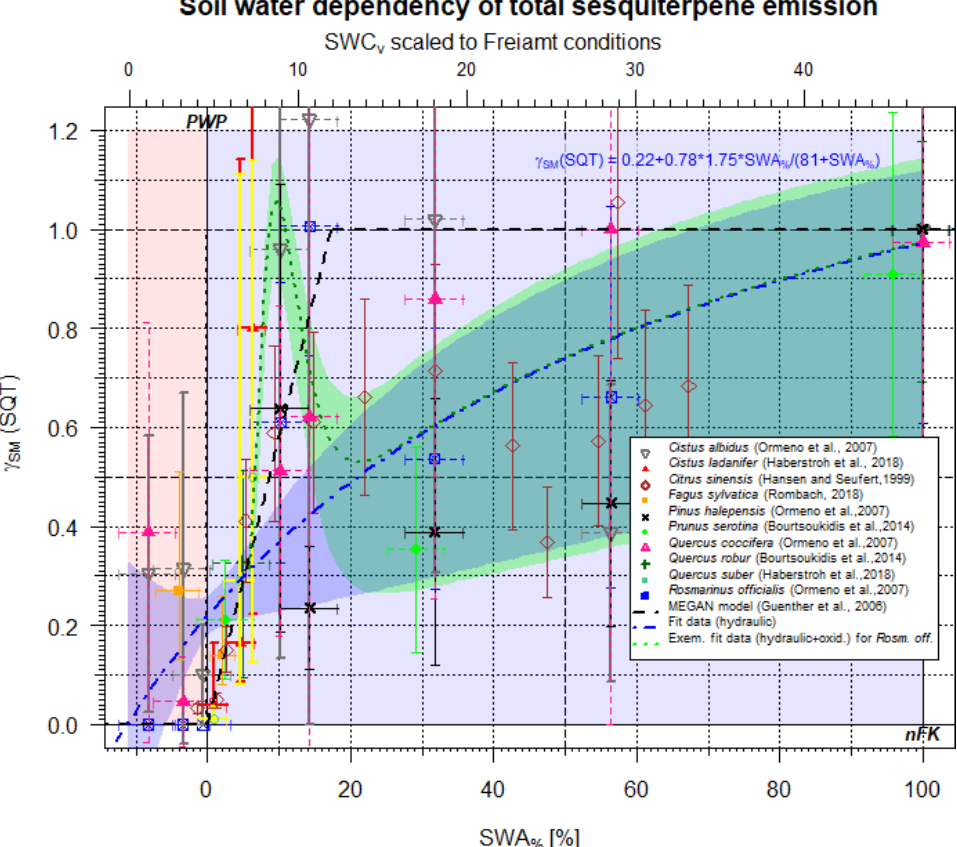
Figure 3. Scaling parameter γ SM (SQT) for the effect of soil moisture on SQT emissions as a function of SWA % (lower x axis) and, for comparison, the SWC v for a selected condition (upper x axis). Data points represent observations; different colors refer to different studies. The dashed black line displays the approach by Guenther et al. (2006, 2012) for isoprene only. The blue line displays the present form. The pointed green line represents an exemplary fit to γ SM (SQT) based on Cistus and Rosmarinus officialis